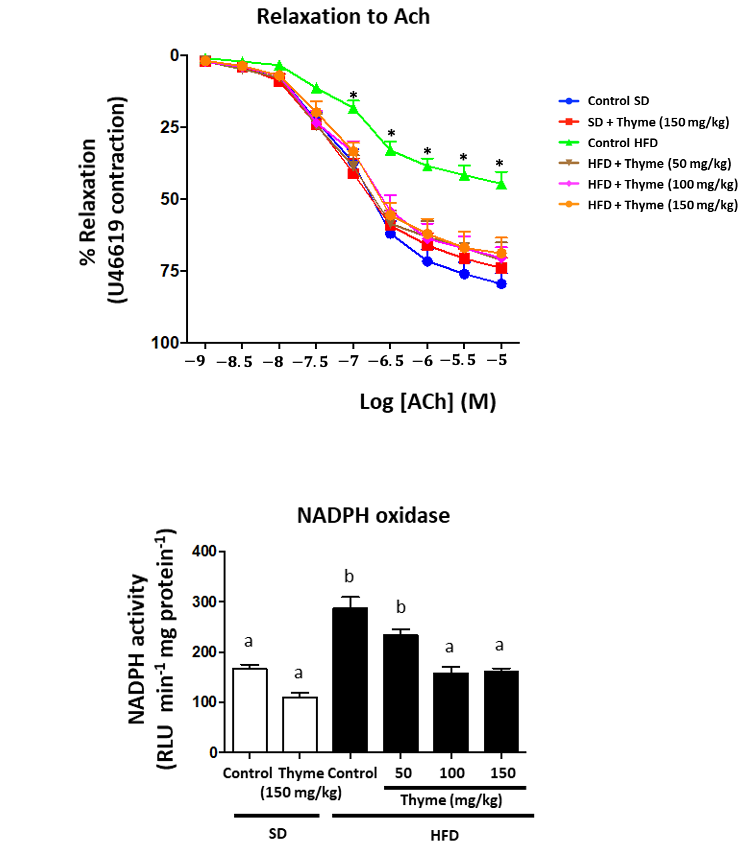
Figure 10. Effects of Thyme extract administration on aortic endothelial function: ( A ) endothelium- dependent relaxation to acetylcholine after contraction with U46619; ( B ) aortic NADPH oxidase activity. Data are expressed as means ± SEM ( n = 10). Groups with different letters statistically differ ( p < 0.05).